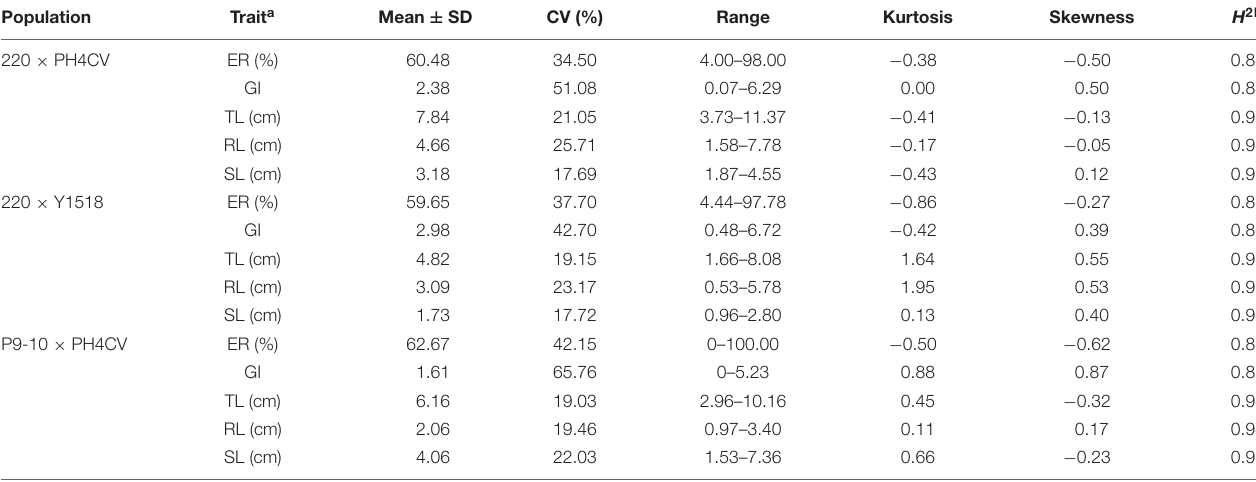
TABLE 1 | Mean and heritability ( H 2 ) estimates for traits related to low-temperature germination in population 220 × PH4CV, 220 × Y1518, and P9-10 × PH4CV. Population Trait a Mean ± SD